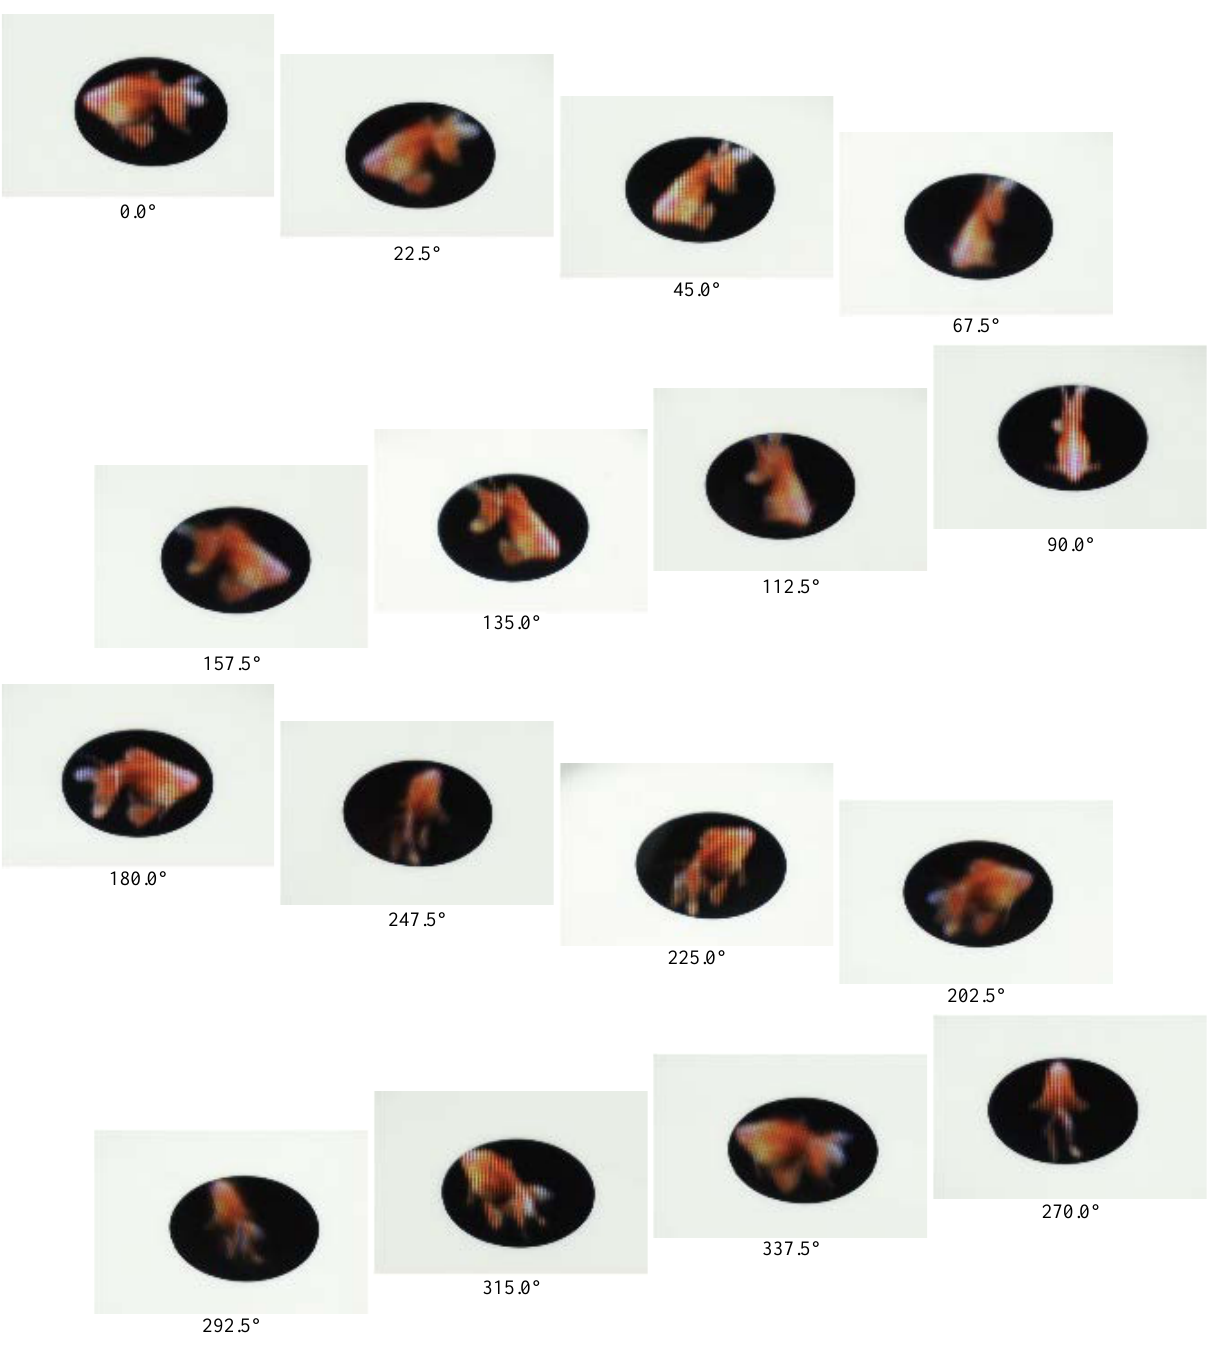
Figure 9. The 360-degree 3D image generated by non-tracking technique observed from 16 direc- tions.